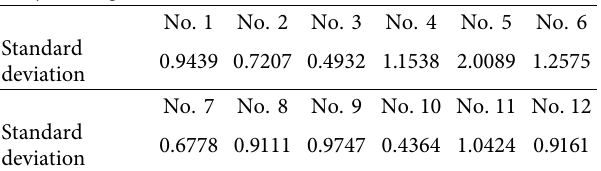
Figure 2: The NS value of the 12 provinces ʼ indexes in the six years. (a) 2015. (b) 2016. (c) 2017. (d) 2018. (e) 2019. (f) 2020. Table 4: The standard deviation of NS of the provinces, respec- tively, during 2018 to